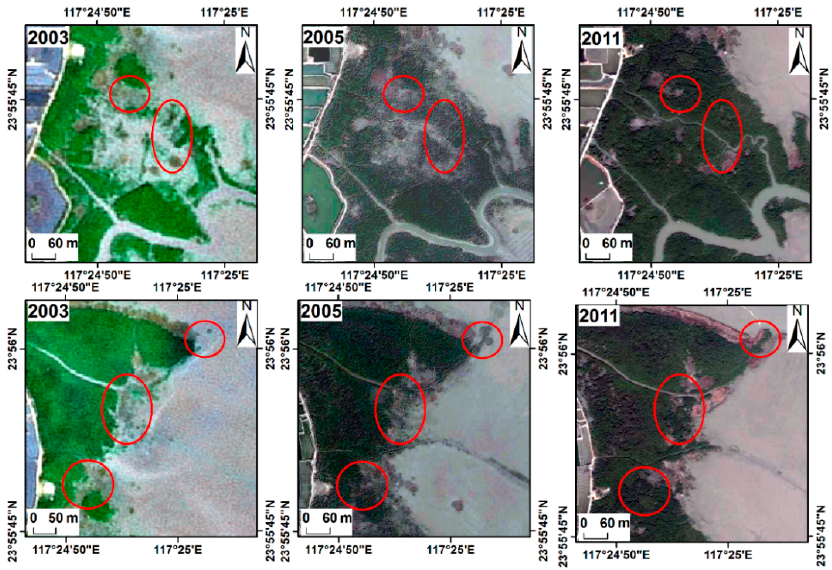
Figure 8. S. alterniflora shrinkage (red ovals) caused by mangrove replantation from 2003 to 2011.